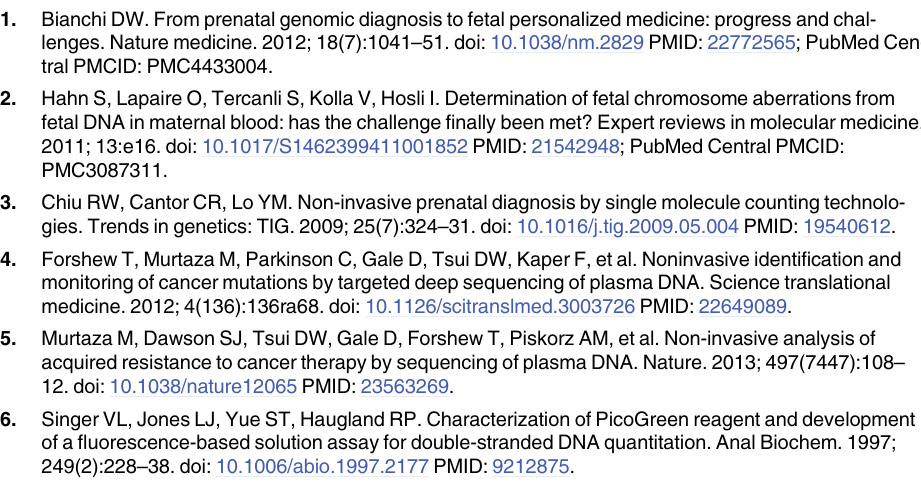
S2 Fig. Fluorescence electropherogram of Frozen-DNA, FFPE-DNA and Trizol-DNA mea- sured with a 2200 TapeStation. The gel image of Fig 2 is presented as an electropherogram overlay. S3 Fig. Agarose gel electrophoresis of Frozen-DNA, FFPE-DNA and Trizol-DNA with SYBR Green I staining. (A) DNAs (500 ng/lane) were electrophoresed on an agarose gel and stained with SYBR Green I. Lane 1, Frozen-H1; lane 2, Frozen-H2; lane 3, Frozen-H3; lane 4, FFPE-H1; lane 5, FFPE-H2; lane 6, FFPE-H3; lane 7, Trizol-h1; lane 8, Trizol-h6; and lane 9, Trizol-h7. (B) The fluorescence intensity of each lane was measured using a CS Analyzer 3 (Atto Co., Tokyo, Japan) and is expressed as a value relative to Frozen-H1 intensity. The mean and standard deviation of relative fluorescence were determined for each group of Frozen- DNAs (lanes 1 to 3), FFPE-DNAs (lanes 4 to 6) and Trizol-DNAs (lanes 7 to 9). The fluores- cence intensities of dsDNA in Trizol-DNAs were significantly lower than those of Frozen- DNAs ( (cid:3) p = 0.025) and FFPE-DNAs ( (cid:3)(cid:3) p = 0.002, by Student ’ s t -test). S1 Table. Primer sequences used in this study. S2 Table. NanoDrop data of original DNA